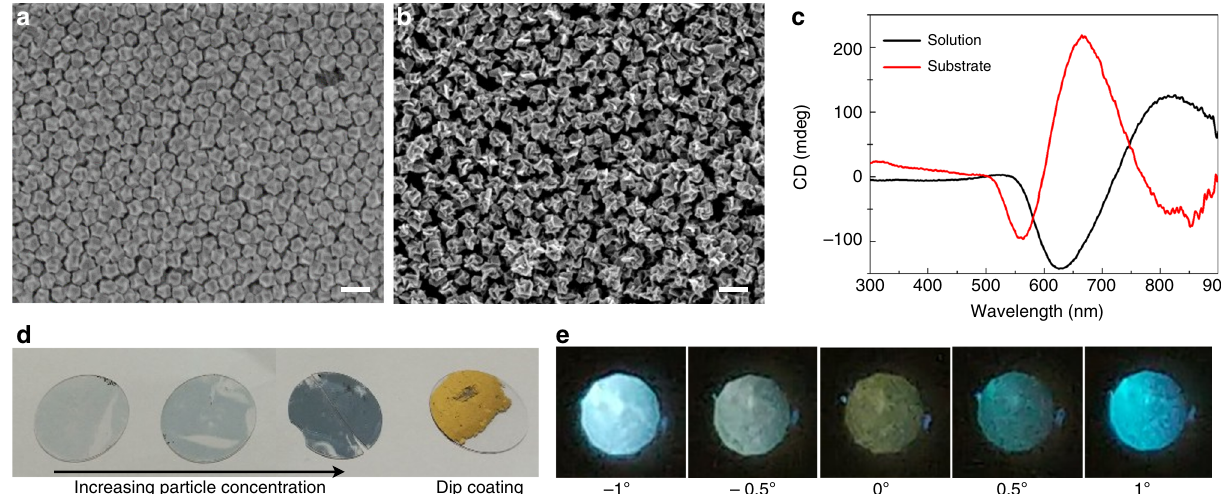
Fig. 6 Morphology and optical characteristic of the substrates coated with 432 helicoid IV. a , b Large-area SEM image of the substrate coated with nanoparticles by the dip-coating method. Two different types of 432 helicoid IV, made with 0.1 mM ( a ) and 0.2 mM ( b ) of Cys concentration, were used for coating. A monolayer or bilayer of assembled nanoparticles was uniformly generated on the substrate. c CD spectra of nanoparticles in the solution phase (black) and coated on the substrate (red). The coupling of assembled nanoparticles in the fi lm-type results in a signi fi cant change in spectral features compared with the results of the nanoparticle solution. d Photograph of 432 helicoid IV assembled substrates with different concentrations of nanoparticles. For the dip-coating sample, which has the highest packing density, the gold re fl ection color is shown. e Polarization-resolved transmission image of a substrate coated with nanoparticles. The angle of the analyzer was changed from − 1° to 1°. See the Methods section for coating procedures and polarization experiments. Scale bars, 200